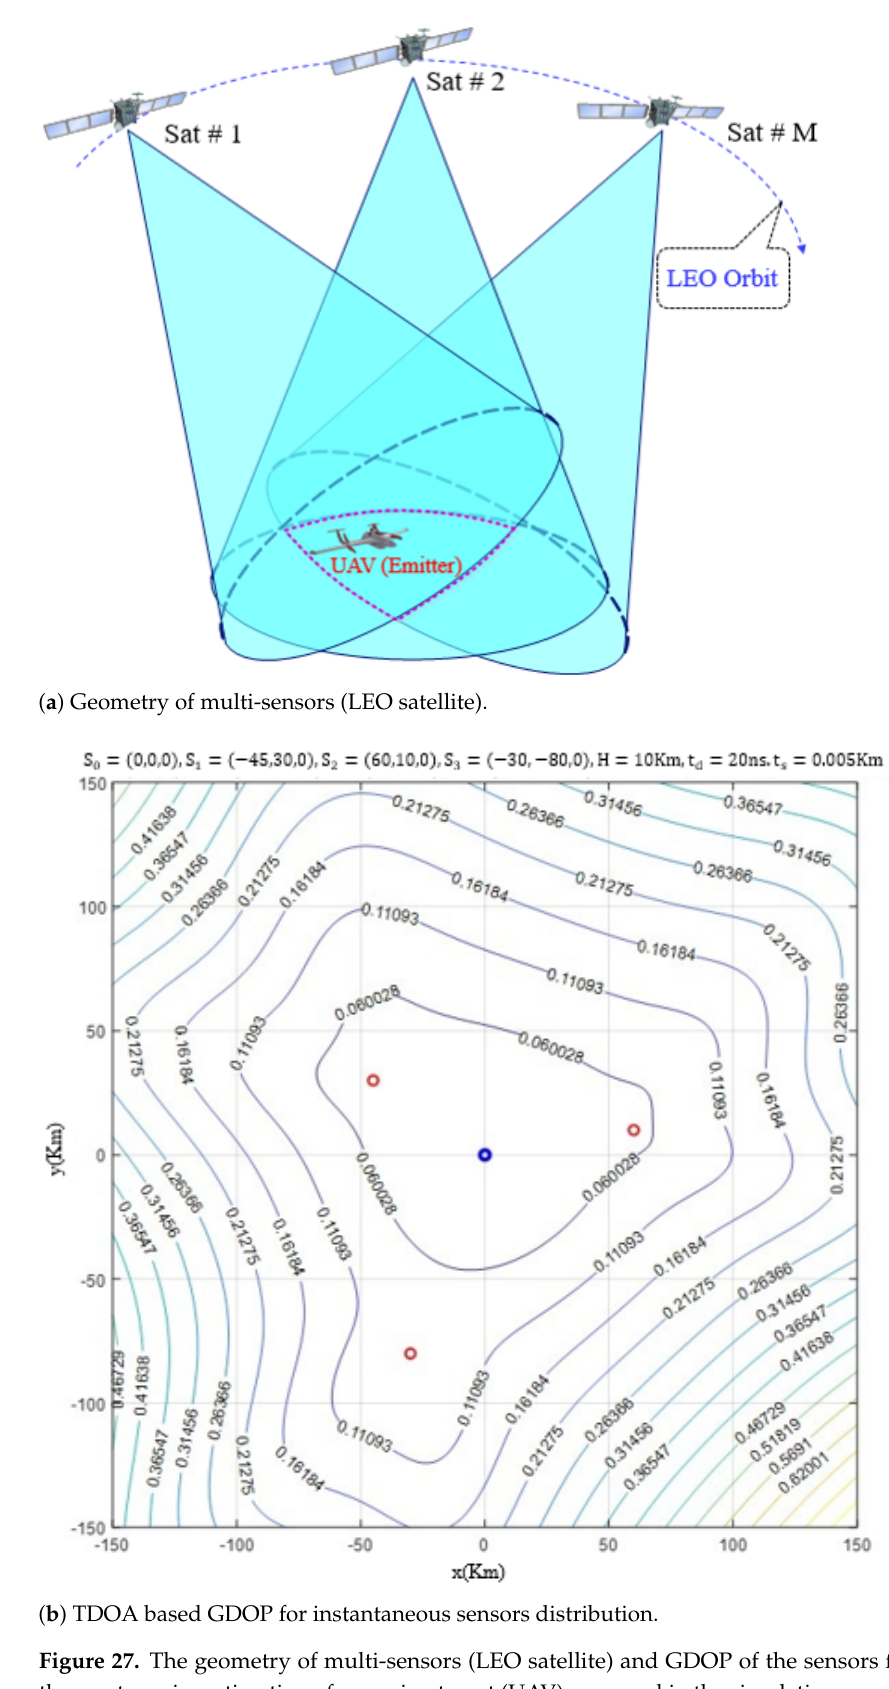
Figure 27. The geometry of multi-sensors (LEO satellite) and GDOP of the sensors for achieving the most precise estimation of a moving target (UAV) proposed in the simulation scenario. Authors’ own